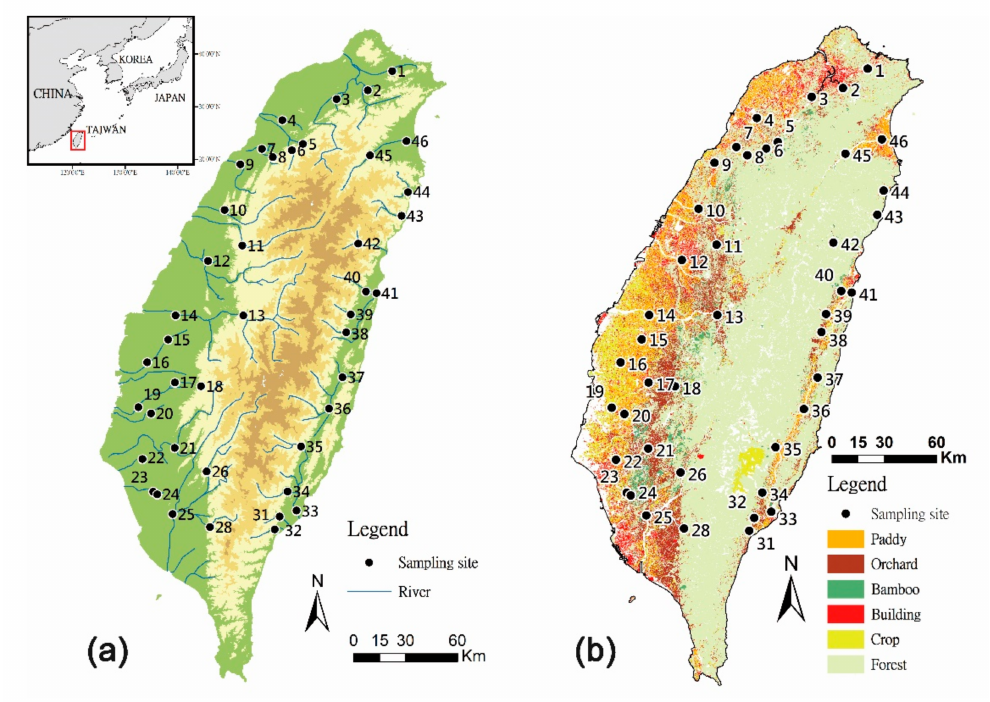
Figure 1. The geographical location of 43 sampling sites ( a ) and land cover map of Taiwan ( b